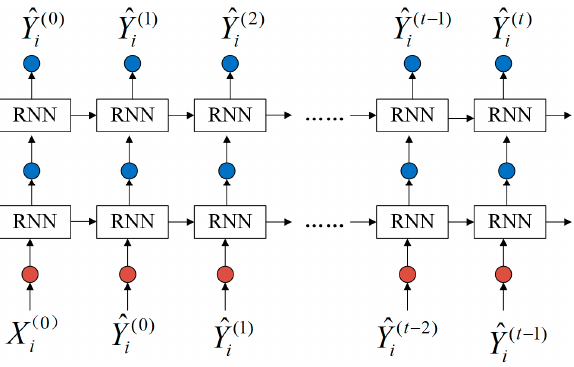
Figure 7. Input-output of the protocol semantic analysis part in the generation phase.